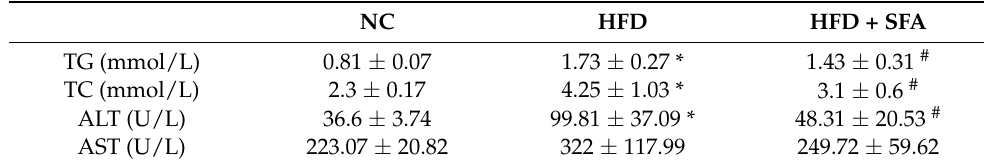
Table 1. Metabolic parameters of serum in C57Bl/6J mice.